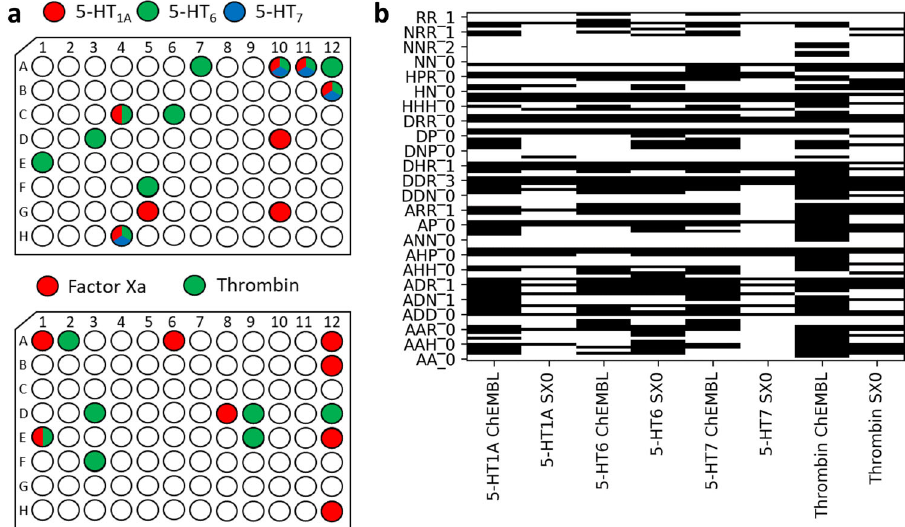
Fig. 2 Experimental validation of SpotXplorer0 on known target classes. a SpotXplorer0 pilot library screening yielded a diverse set of con fi rmed hits for validated GPCR and protease drug targets. Hits are denoted by color in their respective plate positions (upper panel: 5-HT 1A with red, 5-HT 6 with green, 5- HT 7 with blue, lower panel: factor Xa with red, thrombin with green). b The handful of hit compounds from SpotXplorer0 represents the majority of pharmacophore models (black) that occur over the respective sets of (typically 4 – 11 times more) fragment-sized ligands in the ChEMBL database (Percentages are reported in Table 1).